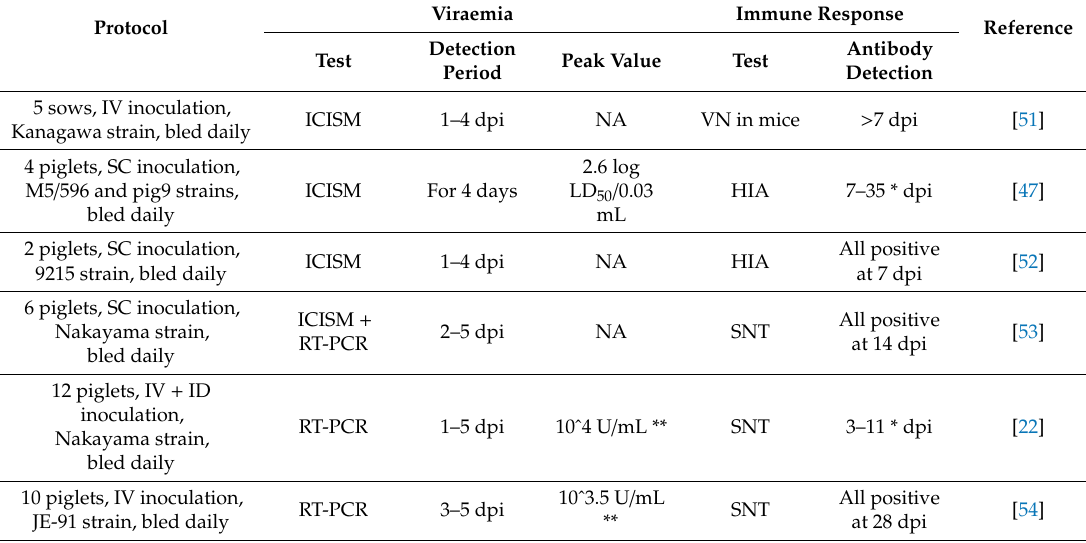
Table 1. Viraemia and active immune response in pigs after Japanese encephalitis virus (JEV) experimental